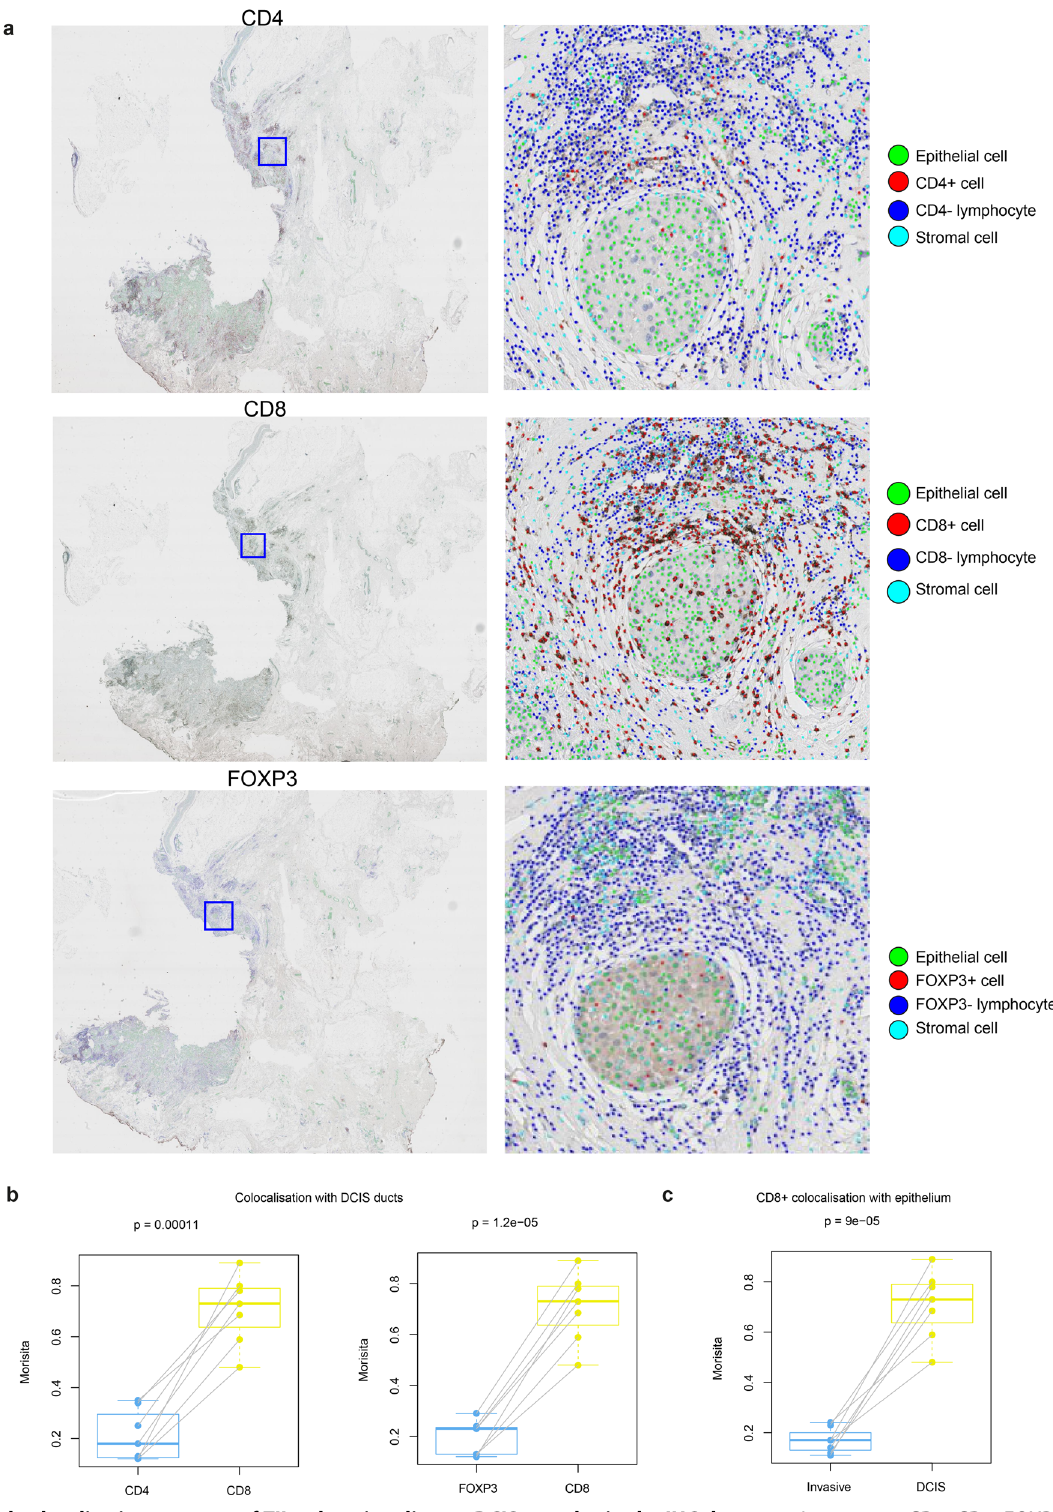
Fig. 7 Spatial colocalisation patterns of TIL subset in adjacent DCIS samples in the IHC dataset. a Low power CD4, CD8, FOXP3 IHC images of a sample and high-resolution images of a region of DCIS showing single-cell detection and classi fi cation using DRDIN and SCCNN. b Boxplots showing differences in DCIS immune colocalisation score between CD8 + , CD4 + and FOXP3 + cells using paired tests. c Boxplots showing the difference in CD8 + cell colocalisation between DCIS and invasive epithelium indicating differential immune response within the same sample in different compartments. DCIS immune colocalisation score is referred to as Morisita to conserve space in the